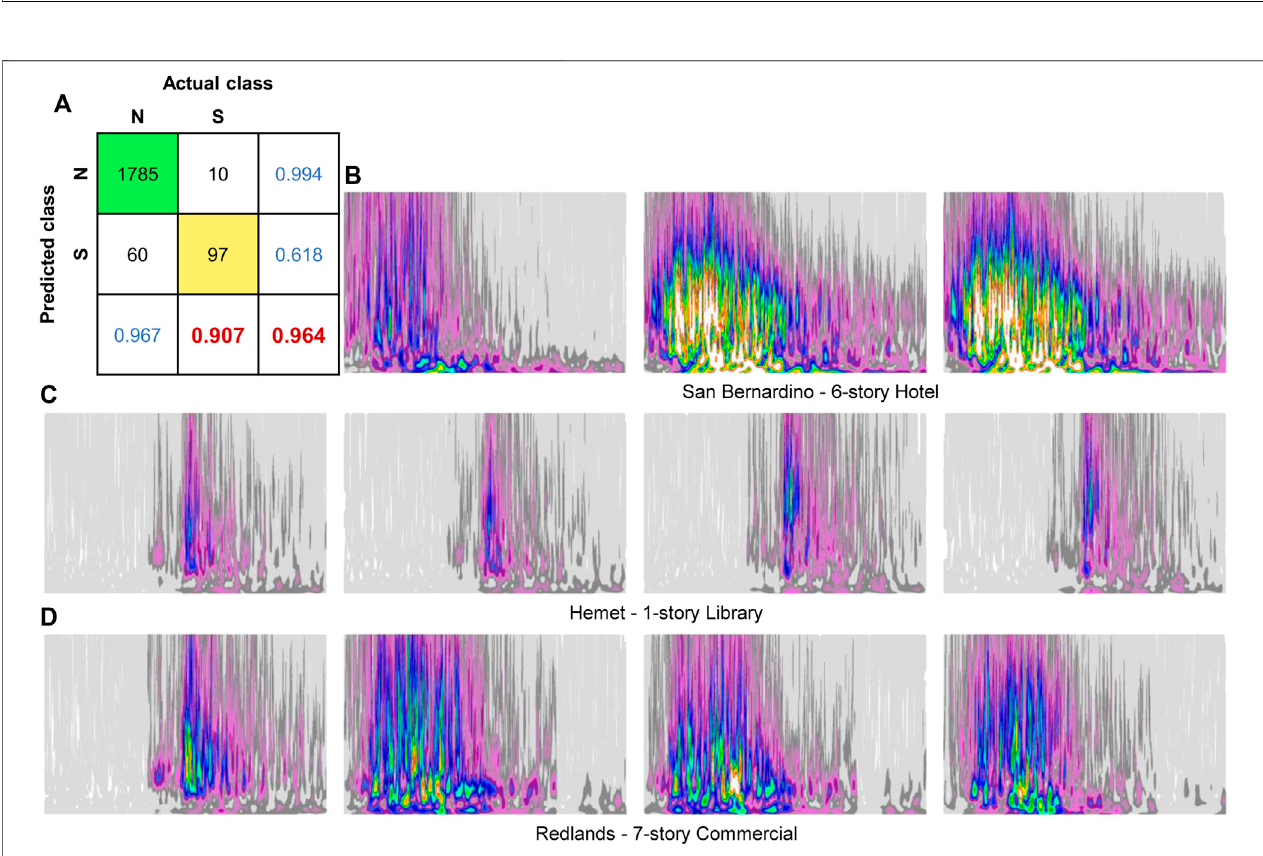
FIGURE 9 | Identi fi cation results for real monitored seismic responses: (A) confusion matrix of VGG19 model identi fi cation results, (B) wrong classi fi cations for 6- story hotel, (C) wrong classi fi cations for 1-story library, and (D) wrong classi fi cations for 7-story commercial of fi ce building.